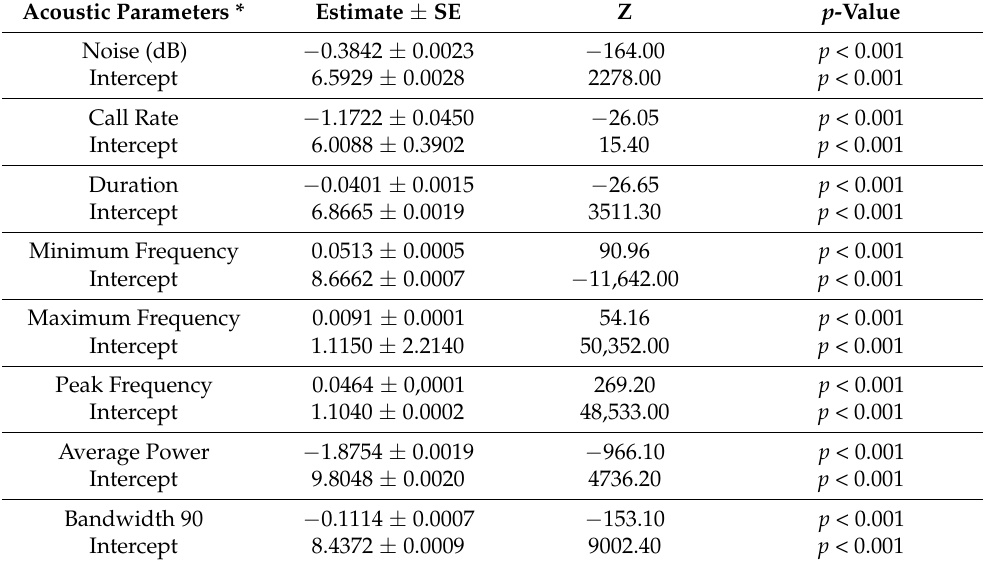
* Data for all variables were compared between close area and far area; the close area representing the reference group.